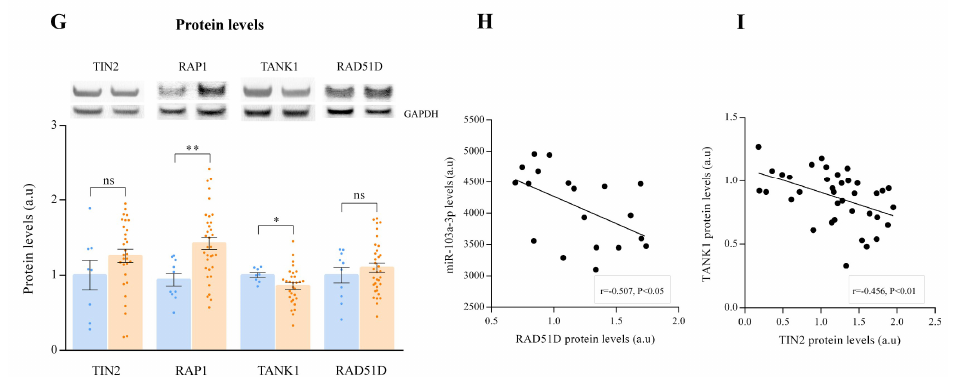
Figure 1. Dot plot graph of mRNA, miRNA and protein expression levels of main molecules associated with telomere homeostasis. ( A ) Genes of shelterin complex. ( B ) Genes involved in the maintenance shelterin complex. ( C ) CTCF and cohesin complex genes. ( D ) Genes involved in the telomere DNA repair. ( E ) miRNAs targeting TERF1 , POT1 , RAD21 and RAD51D . ( F ) Correlation of RAD51D mRNA levels with left ventricular end-systolic (LVESD) and left ventricular end-diastolic (LVEDD) diameters. ( G ) TIN2, RAP1, TANK1 and RAD51D protein levels. ( H ) Correlation of RAD51D protein levels with miR-103a-3p expression levels. ( I ) Correlation of TIN2 with TANK1 protein levels. The results were obtained by mRNA-sequencing SOLiD 5500XL platform and ncRNA- sequencing Illumina HiSeq 2500 platform. Data are presented as the mean ± SEM. au, arbitrary units. Ischemic cardiomyopathy patients (orange), controls subjects (blue). Left ventricular end-systolic diameter (black), left ventricular end-systolic diameter (grey). * p < 0.05, ** p < 0.01, *** p <